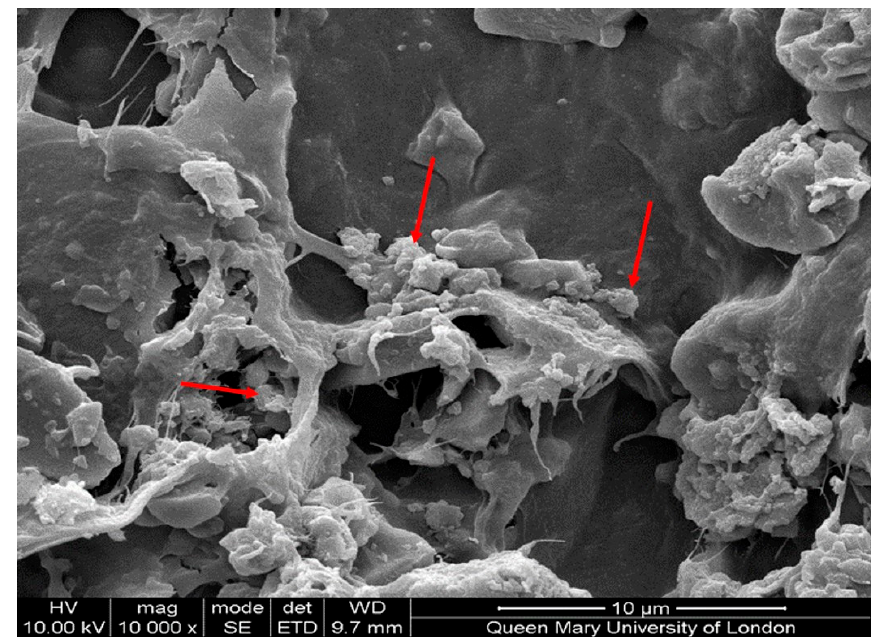
Figure 11. The SEM image of the calcium orthophosphate precipitation on the scaffold after the bioactivity test is shown by arrows.